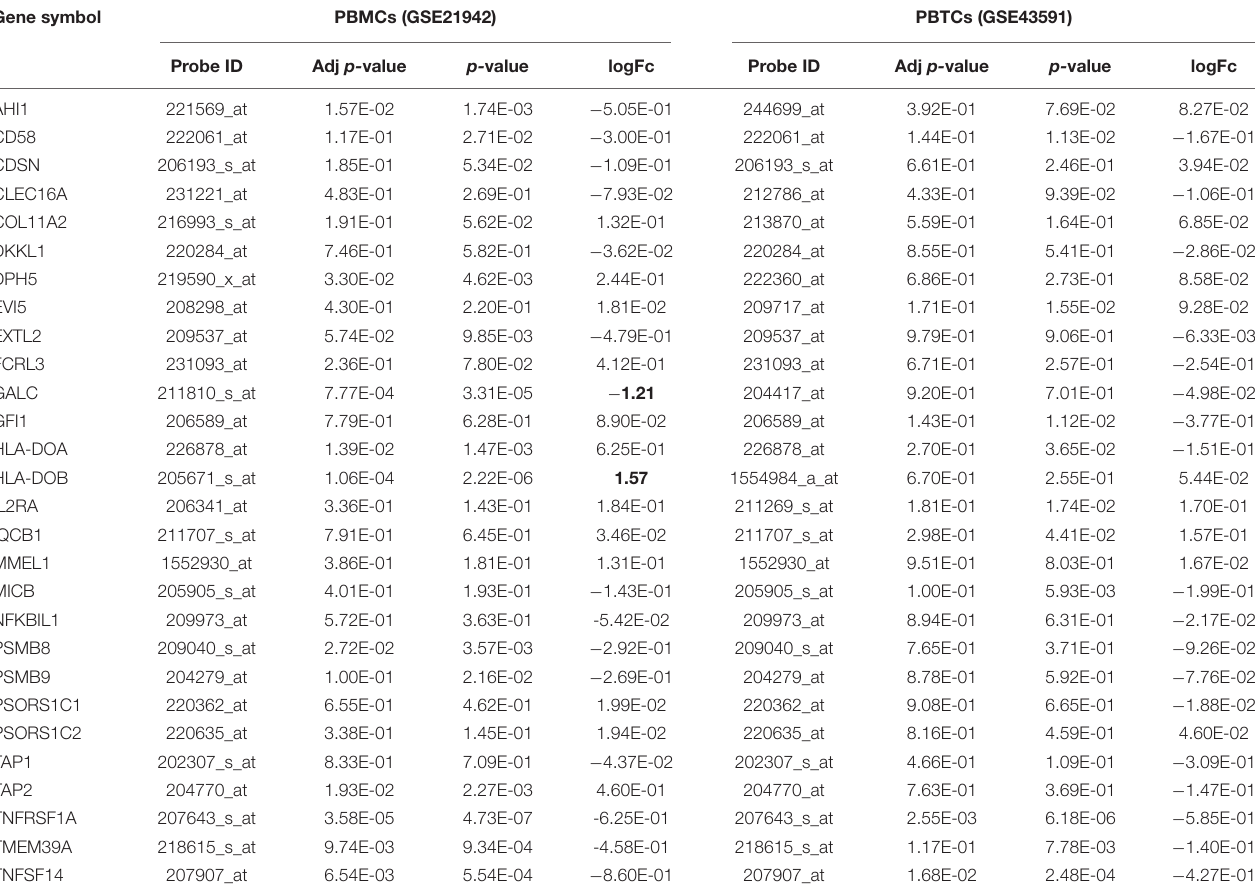
TABLE 2 | Significant expression of common genes in PLINK and VEGAS2 analyses of MS.